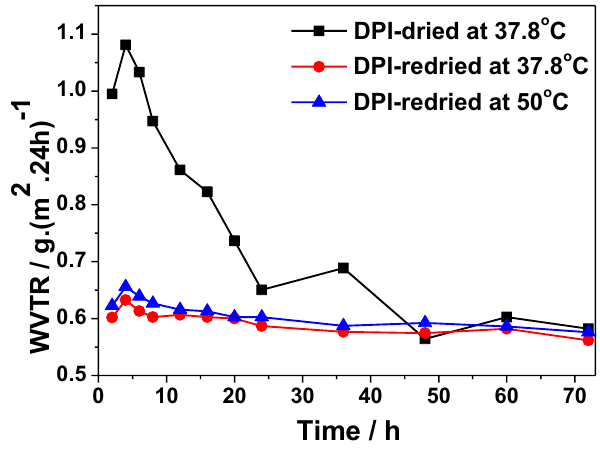
Figure 10. Water barrier property of DPI films (45 μm in thickness, testing at 85% RH for 72 h).